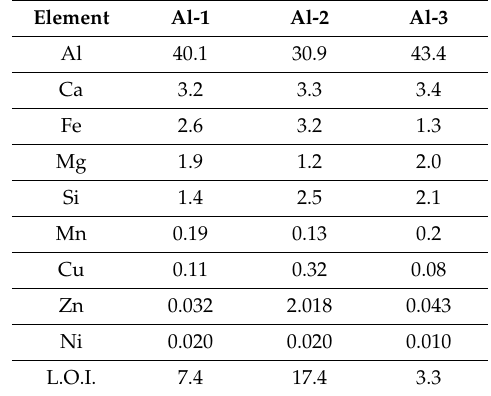
Table 1. Chemical composition of the studied aluminum drosses (wt %).